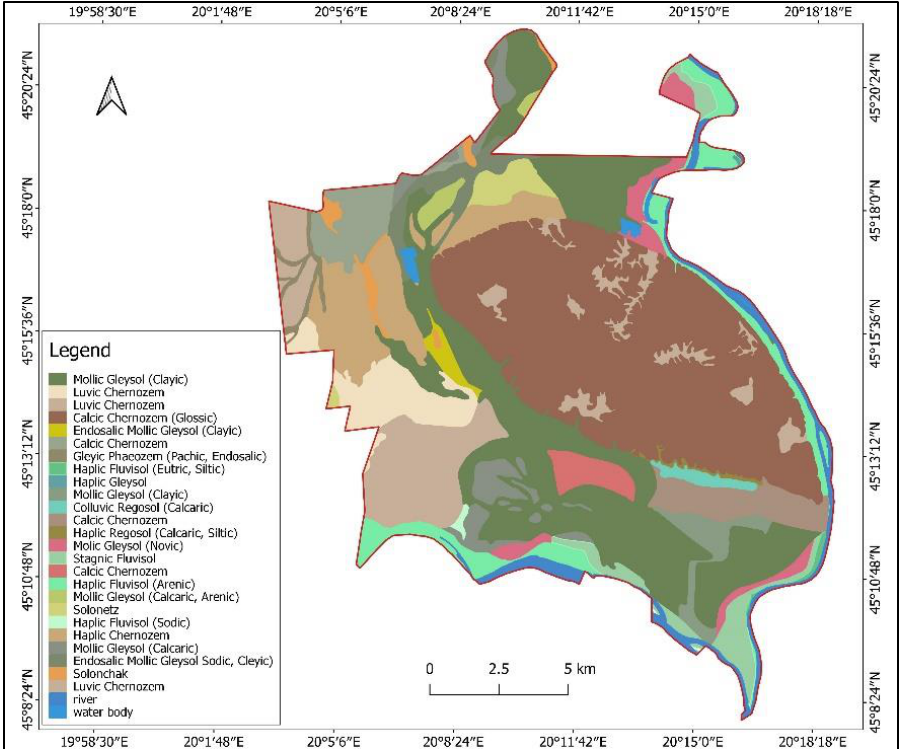
Figure 5. Main soil types of the study area. Calcic Chernozem, Stagnic Fluvisol, Molic Gleysol (Novic), Haplic Gleysol, different varieties of Fluvisol, have a good water-holding capacity. This type of soil is distributed in the area of loess plateau, higher and lower river terrace, and in the alluvial plain. Soils such as Solonetz, Solonchak, different varieties of Regosol, and different varieties of Gleysol (except Molic Gleysol (Novic) and Haplic Gleysol) have poor water-holding capacity and were ranked significantly lower. These are mostly located in the lower parts of the study area with small distribution on lower and higher river terraces. Table 6. Soil type over the research area and its area expressed in km 2 and percentage. Soil